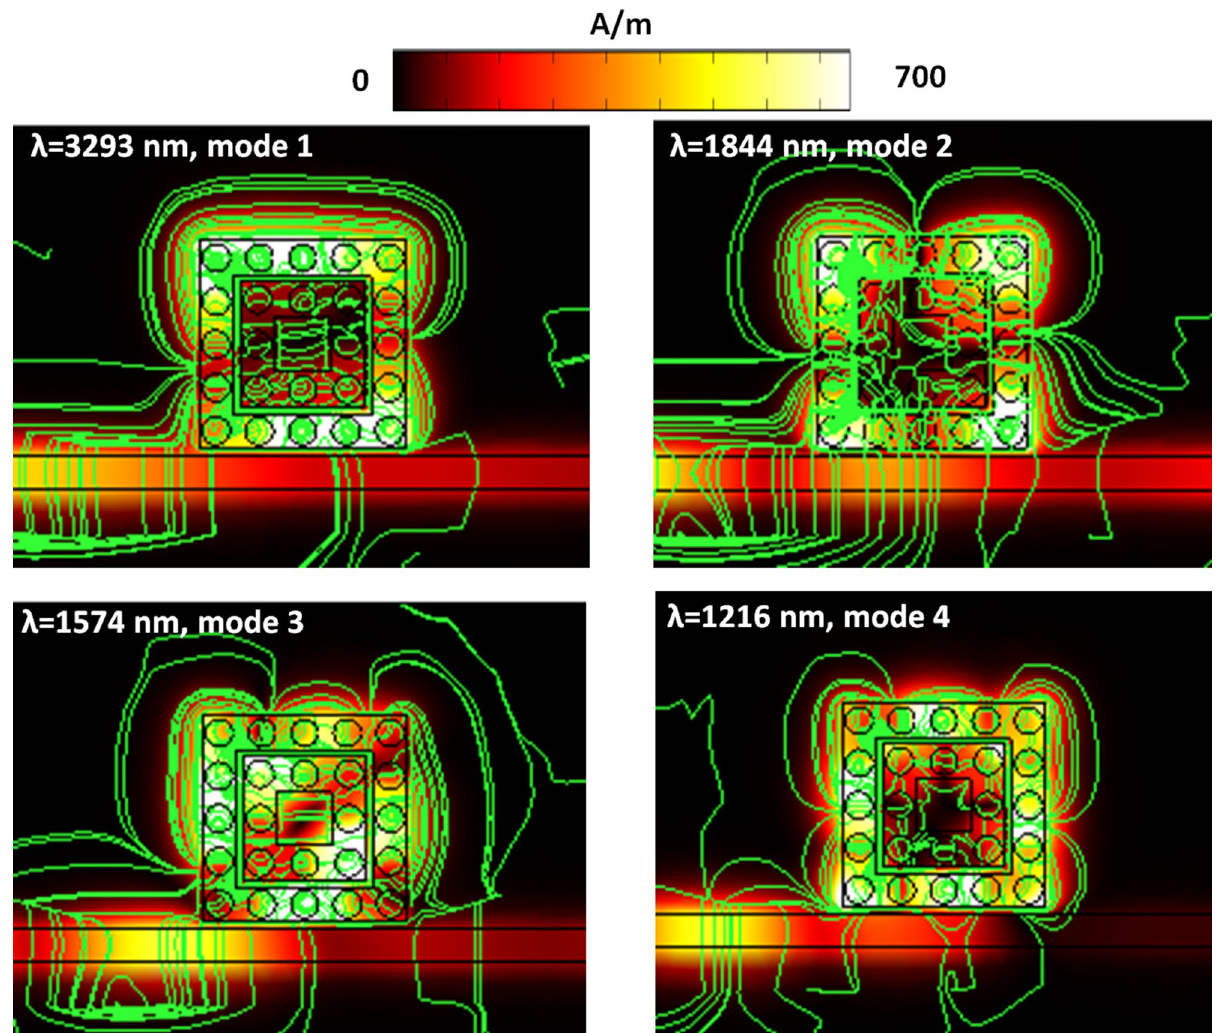
Figure 11. The magnetic field intensity (|H|, including the surface electric force lines (green lines)) of resonant fluids ( n = 1.33 as an example) around the case 3 structure from modes 1 to 4,